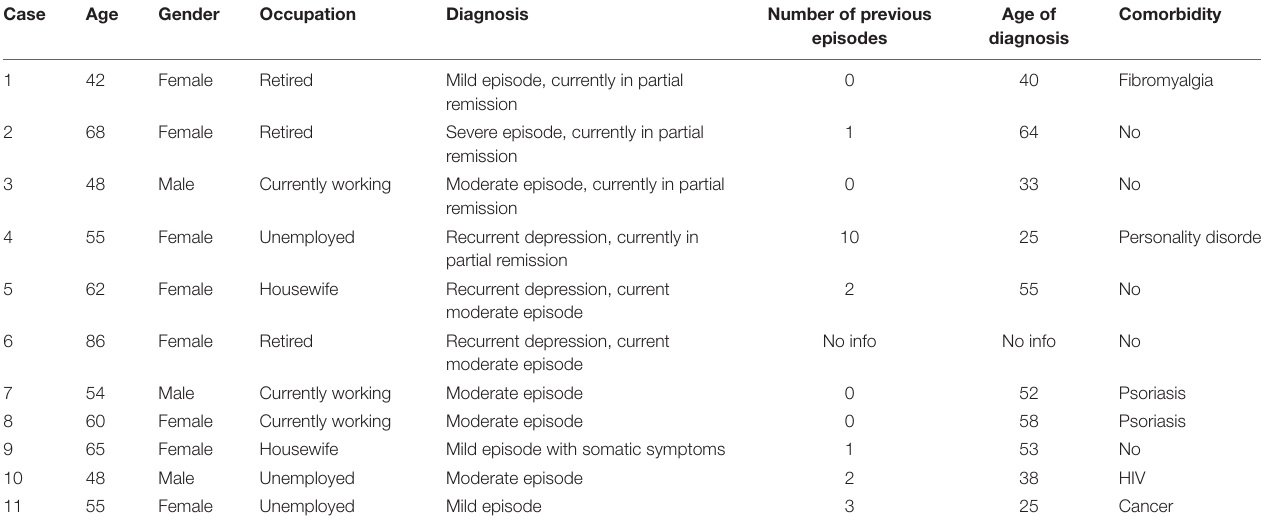
TABLE 2 | Sociodemographic and clinical characteristics of the patients with depression.